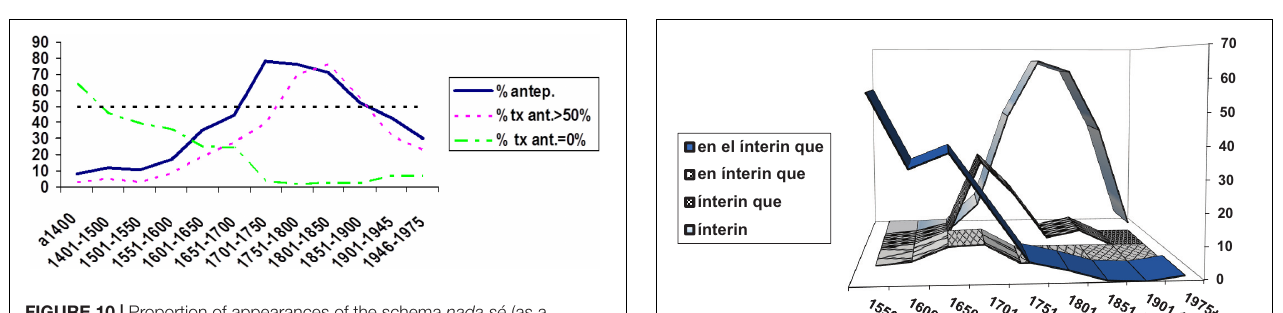
FIGURE 10 | Proportion of appearances of the schema nada sé (as a percentage of the sum of these cases and those of the type no sé nada : % antep.), proportion of texts where nada “nothing” appears before the verb in more than 50% of cases (% tx ant. > 50%) and proportion of texts where there are no cases of nada “nothing” before the verb (% ant. = 0%). Data from CORDE.